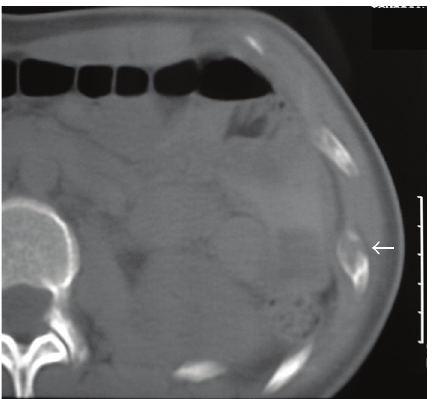
Figure 2: CT shows a soft tissue density lesion causing severe thinning of the bone cortex. The apparent area of cortical disruption (arrow) was not confirmed histologically and can be attributed to partial volume